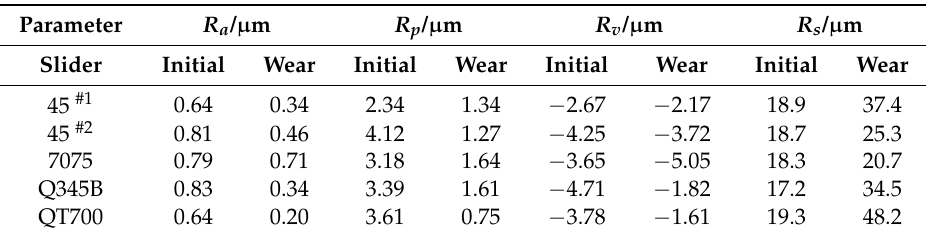
Table 3. Changes in surface roughness of metallic sliders surfaces after